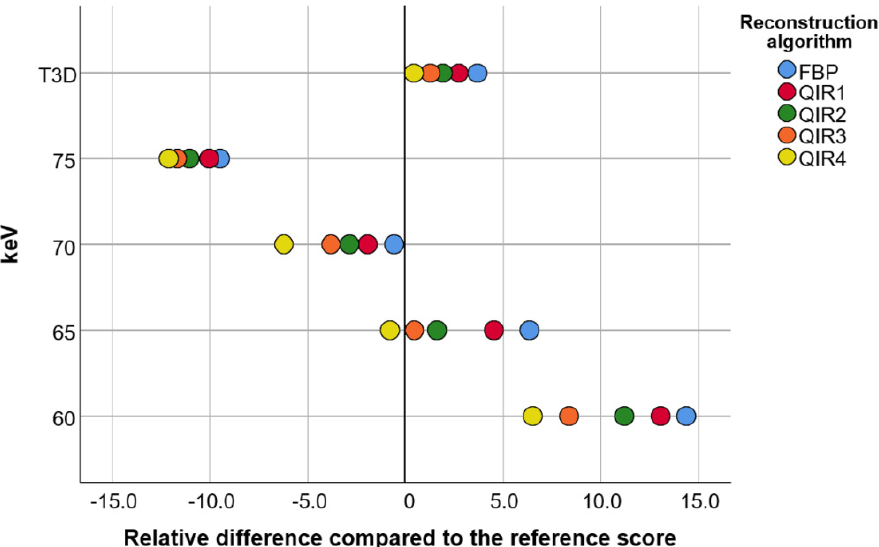
Figure 3. Data from a photon-counting detector CT scan of an anthropomorphic chest phantom with an insert for calcium scoring. The calcium score of image reconstructions with 65 to 75 keV as well as with T3D (and Quantum Iterative Reconstruction—QIR—at various strength levels) range within 10% of the reference score acquired with an energy-integrating detector CT. Image reconstruction with 70 keV and FBP, 65 keV and Quantum Iterative Reconstruction (QIR) at a strength level of 3 or 4 as well as with T3D and QIR at strength level 4 results in a deviation of <1% from the reference score. The lower the keV levels, the wider the distribution of calcium scores between QIR reconstructions at various strength levels.